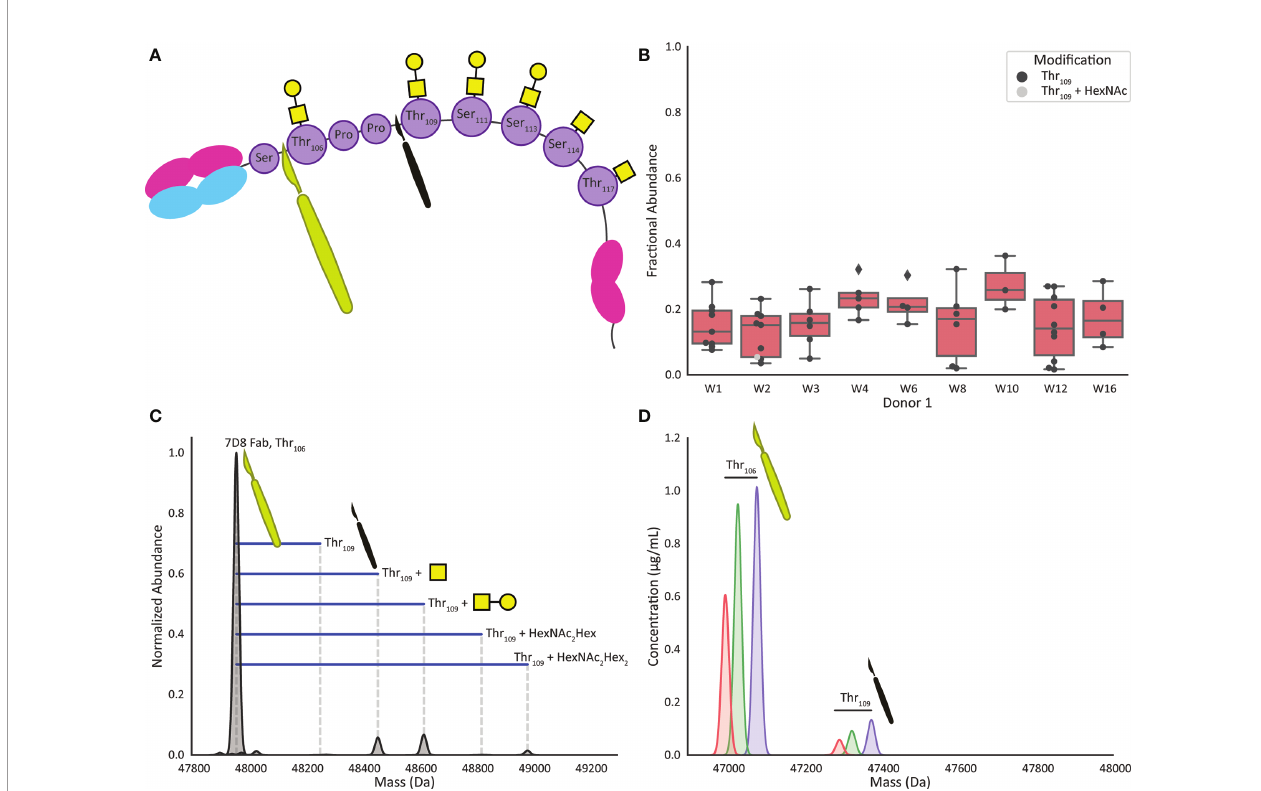
FIGURE 2 | Digestion by OgpA of recombinant mIgA1 and human milk sIgA1 results in highly speci fi c cleavage and formation of Fab fragments. (A) Cartoon of an IgA1 molecule highlighting the preferred cleavage site of O -glycopeptidase from Akkermansia muciniphila (OgpA). The large yellow scalpel indicates the preferred Thr 106 site, the smaller black scalpel shows the observed missed cleavage site (digestion at Thr 109 ) adding Thr 106 Pro 107 Pro 108 to the Fab sequence. (B) The boxplots show the fractional abundance of the Fab fragments resulting from the Thr 109 missed cleavage as compared to the corresponding Thr 106 base peak. When observed, the Thr 109 missed cleavage is generally lower than 20% in abundance compared to the Thr 106 peak, and almost exclusively non-glycosylated at Thr 106 . (C) Overnight incubation of monoclonal mIgA1 with OgpA resulted in highly selective digestion at the O -glycosylation site Thr 106 , as determined by the detection of the calculated mass of the Fab. Minor satellite signals were detected, originating from the missed cleavage at Thr 109 , carrying one HexNAc, HexNAc+Hex, or 2 (HexNAc+Hex). (D) Extracted ion chromatograms of three selected Fab clones in Donor 1 week 1 that display highly selective digestion at O -glycosylation site Thr 106 , only one additional signal can be observed, digestion at Thr 109 carrying no O -glycan at Thr 106